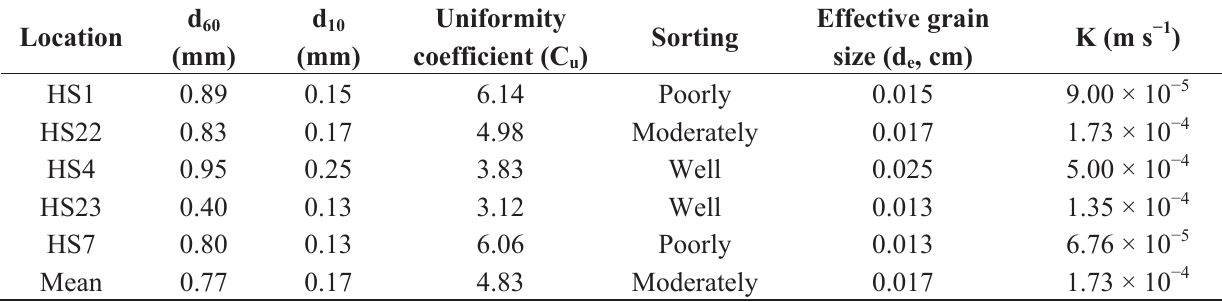
Table 1. Results of grain size analysis for the stream sediments. The hydraulic conductivity (K) was estimated using the Hazen method